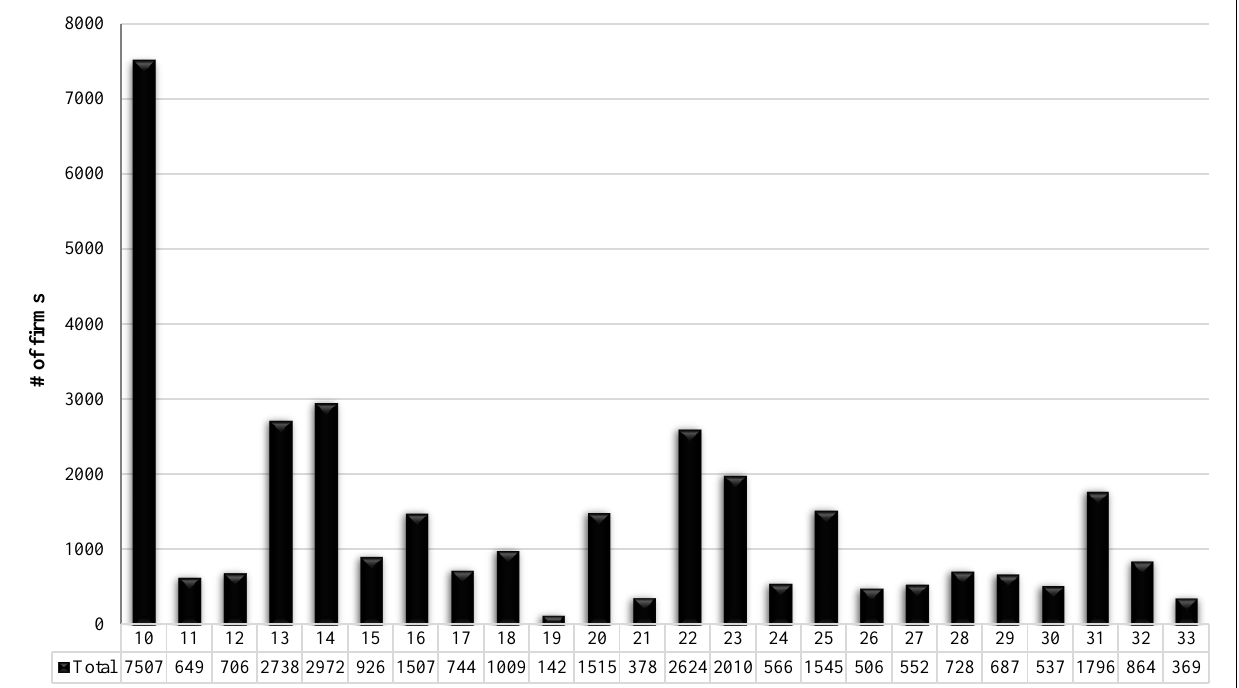
Figure 2. Number of large and medium manufacturing industries based on 2 digit ISIC